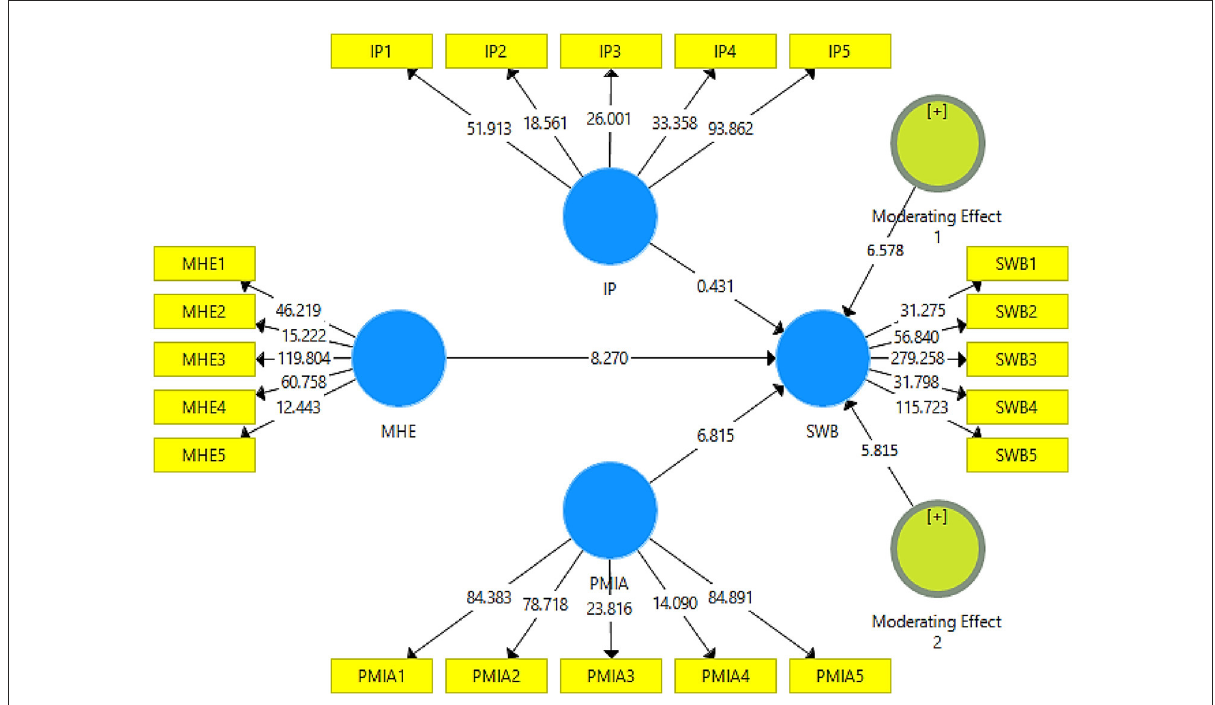
FIGURE3 Structural model. MHE, Mental Health Education; IP, Ideological Passion; SWB, College Student’s Wellbeing; PMIA, Politically Motivated Internet